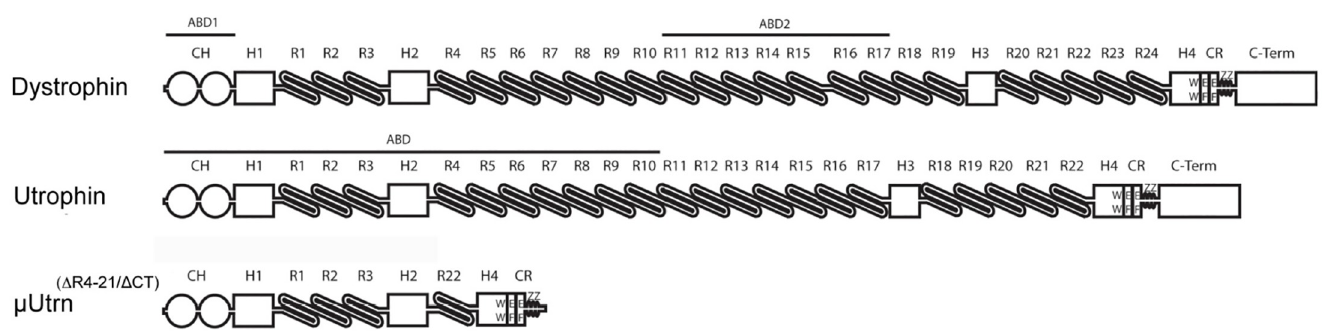
Fig 1. Domain structure of dystrophin, utrophin and μ Utrn. Shown is an illustration depicting the major functional domains of full-length, (427 kDa) dystrophin, (400 kDa) utrophin, and (130 kDa) microutrophin ( μ Utrn). Dystrophin contains two actin-binding domains [ABD1, which has 2 calponin-homology domains (CH), and ABD2), while the single ABD of utrophin is continuous through spectrin-like repeat 10. The central rod domain of dystrophin is composed of 24 spectrin-like triple-helical elements or repeats (R) while utrophin contains 22 repeats, both proteins carry 4 hinge (H) domains. Toward the carboxy-terminus a WW domain within hinge 4 together with a cysteine rich (CR) domain composed of 2 EF-hands, and a Zinc finger domain (ZZ), form a binding domain for beta-dystroglycan. The Carboxyl-terminal domain (C-term) provides binding sites for the syntrophins and dystrobrevins. Micro-utrophin lacks repeats 4–22 as well as the CT domain (Odom,